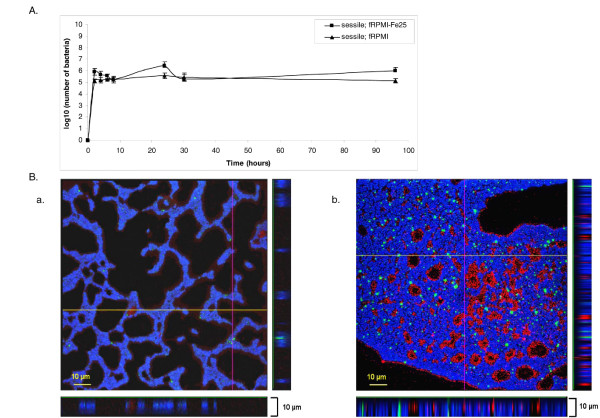
A. The number of bacteria is quantified via the log10 of the number of copies of gmk. Bacteria were pre-incubated overnight in fRPMI and incubated together with catheter fragments in fRPMI (filled diamonds) or in fRPMI-Fe25 (filled squares). The error bars represent the standard deviations. The line that links the data points helps to clarify the results at each time point measured. The time is given in hours in the x-axis. Fifteen samples from three independent cultures were assessed at each time point. B. Confocal laser scanning micrographs of sessile bacteria Bacteria were grown overnight in fRPMI and re-incubated together with polyurethane coated glass fragments in fRPMI-Fe25. Pictures were taken after 4 hrs (a) and after 24 hrs (b) of incubation. For each time point images show the xy-, xz- and yz-planes. The xy and orthogonal images of Staphylococcus epidermidis biofilms showed living cells (blue, syto9 stained) embedded in extracellular matrix (red, Wheat germ-agglutinin Alexa fluor® 633 stained) whereas the green areas (sytox orange strained) represent the dead bacteria. Experiments were performed in triplicate and biofilms were viewed at 100 × magnification.